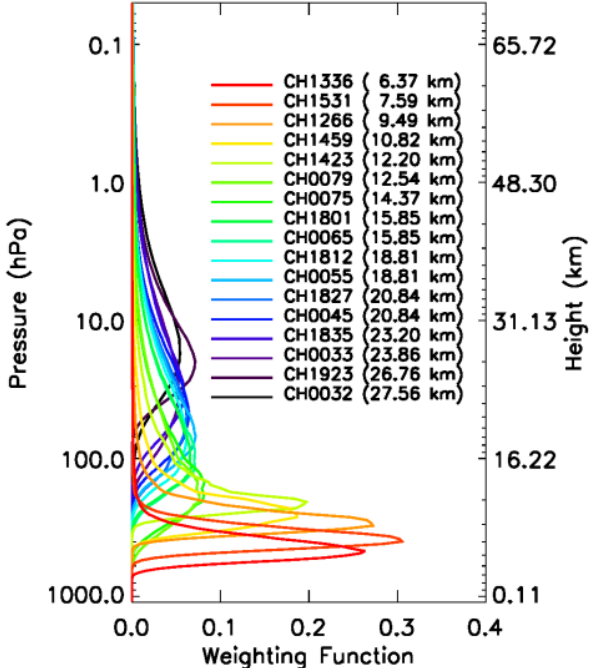
Figure 6. Selected CrIS channels covering temperature and water vapor sounding channels at represented pressures and altitude heights. Table 1. Time series from selected CrIS channels covering temperature and water vapor sounding channels at represented pressures and altitude heights for comparison purposes.